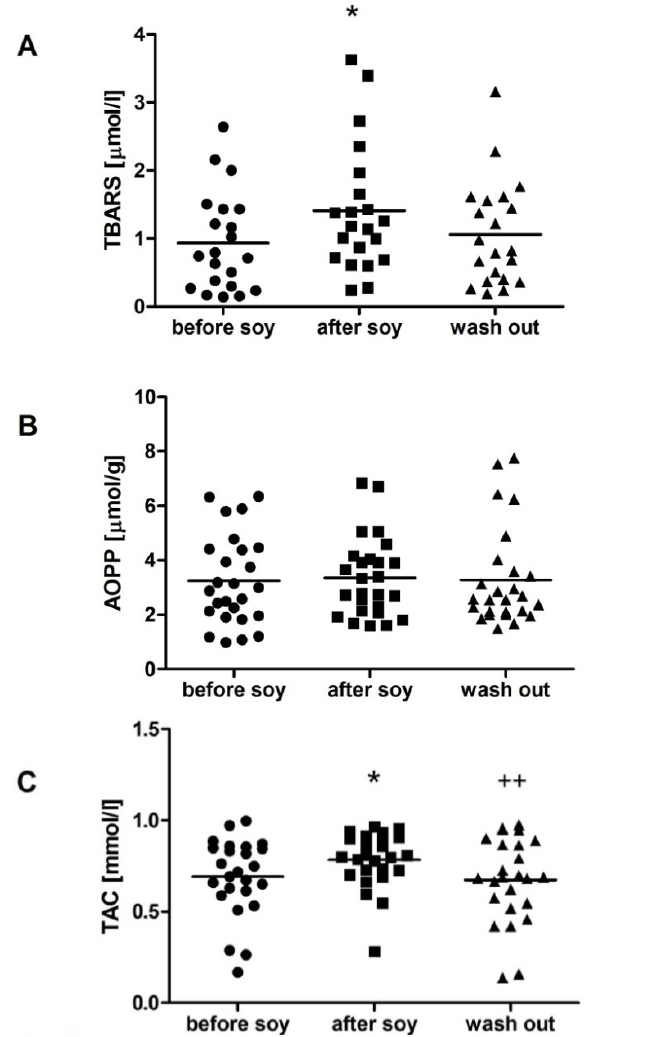
Figure 2. Oxidative stress parameters in men. Soy intake increased thiobarbituric acid reactive substances (TBARS) levels ( A ), but had no effect on advanced oxidation protein products (AOPP; B ). Total antioxidant capacity of plasma (TAC) was increased by one